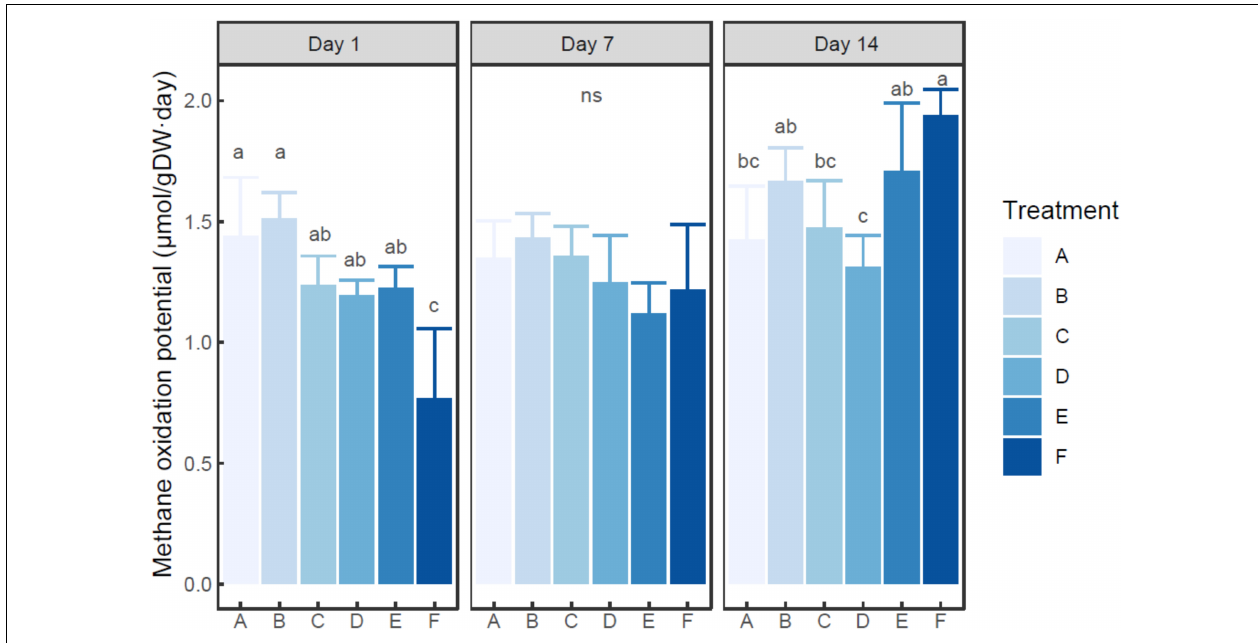
FIGURE 1 | Change of methane oxidation potential in the microcosms with different treatments. Error bar indicates standard deviation ( n = 3). Asterisk indicates the significance between experiment group and control group ( P < 0.05). ‘ns’ indicates no significant difference among treatments at a given time.